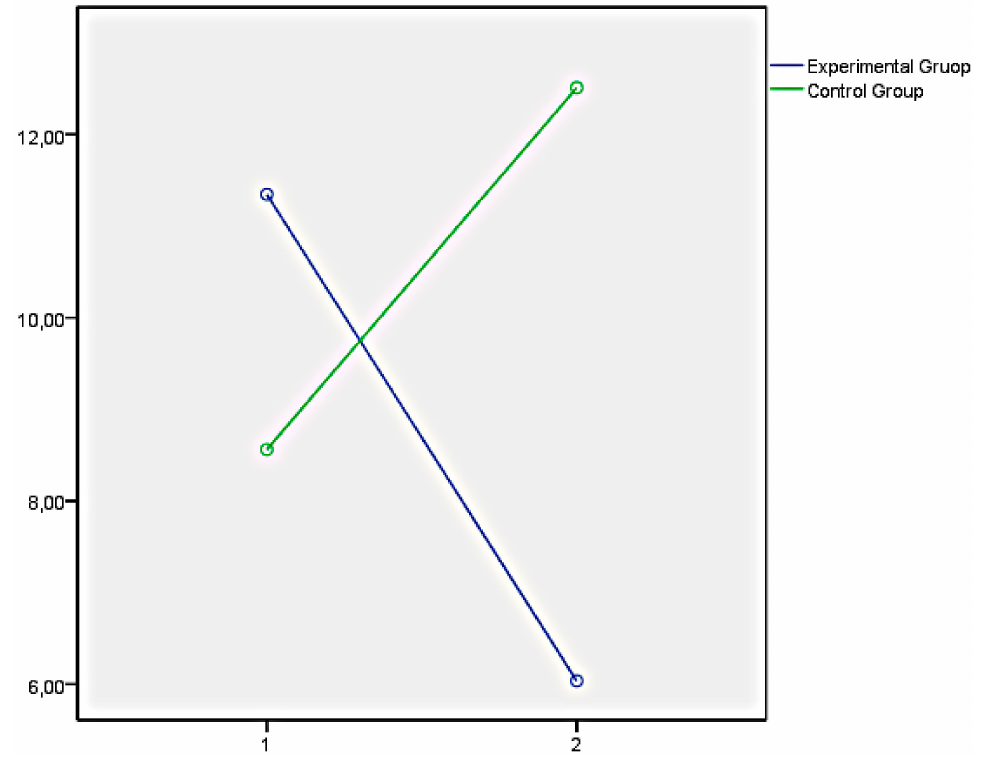
Figure 6. Antisocial behaviour after the educational intervention measured with the Antisocial-Criminal Behaviour